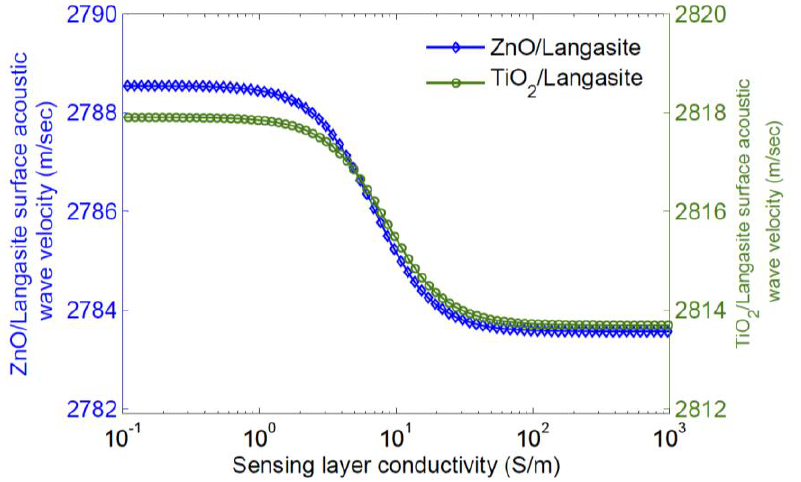
Figure 6. Dependence of velocity on film conductivity. Calculations are for a layer 100 nm